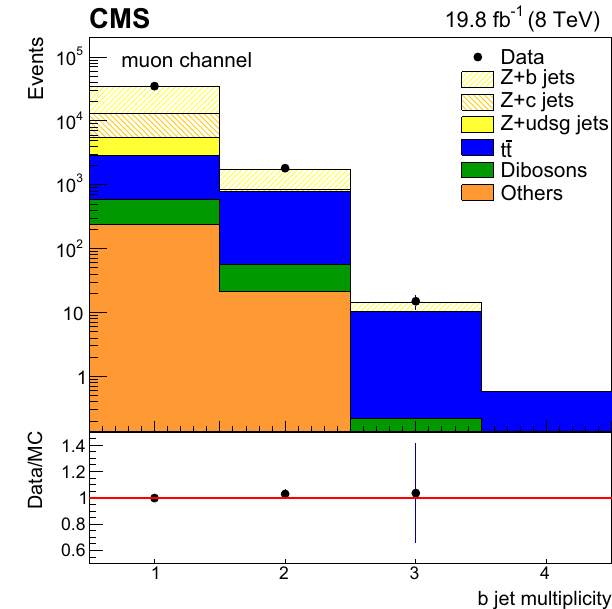
and in both data and simulation in the bottom ratio plots , that show the data to MC ratio